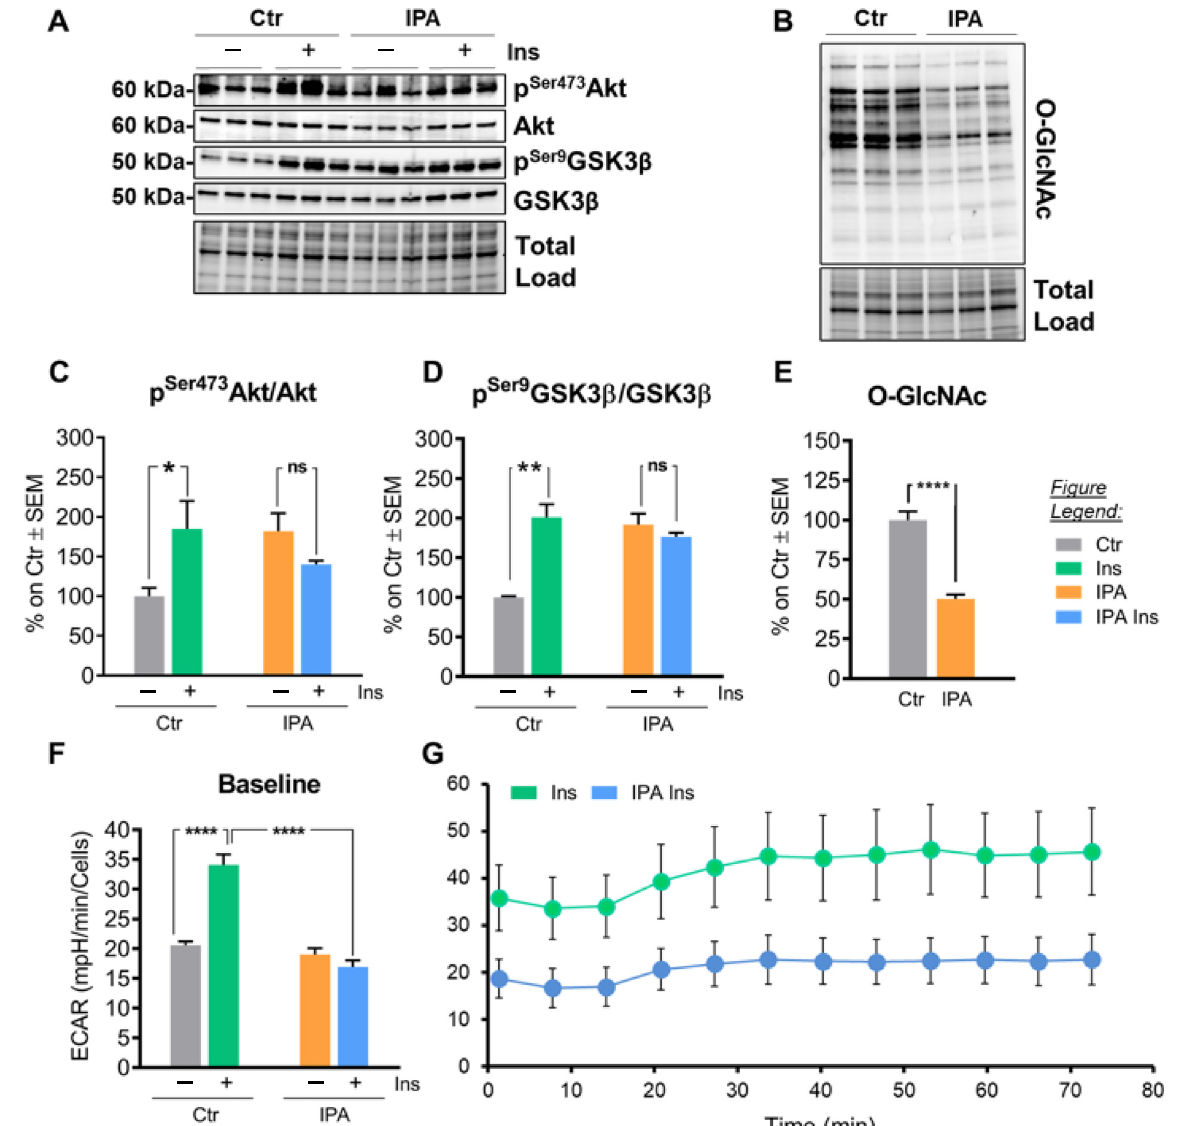
Figure 7. Insulin and palmitic acid (IPA) treatment in SHSY-5Y neuroblastoma cells lead to insulin resistance and reduced protein O-GlcNAcylation. ( A,C ): Analysis of Akt activation status in IPA-treated cells under the stimulus of insulin. Control cells rapidly responded to the insulin stimulus by phosphorylating Akt on Ser473, while IPA-treated cells did not show relevant changes in pSer473Akt/Akt ratio under the stimulus of insulin. Representative blots are reported in ( A ). ( A , D ) Analysis of GSK3 β activation status in IPA-treated cells under the stimulus of insulin. GSK3 β was phosphorylated on Ser9 by Akt in control cells treated with insulin, while IPA pretreated cells were not responsive. Representative blots are reported in ( A ). ( B , E ) Evaluation of global O-GlcNAcylated proteins in IPA-treated cells compared to controls. IPA treatment induced a significant reduction in the overall levels of O-GlcNAcylated proteins. Representative blot is reported in ( B ). ( F , G ) Bioenergetic profile of neuroblastoma cells after insulin treatment. The glycolytic flux, obtained by measuring extracellular acidification rate (ECAR) by Seahorse experiments, of +/ − IPA pretreated neuroblastoma cells after +/ − 30 ′ of insulin incubation. In ( F ) the basal average value of +/ − IPA treated and +/ − insulin stimulated cells is shown; in ( G ) the time-course of the insulin sample +/ − IPA pretreatment is shown. The time-course of non-stimulated cells is shown in Figure S2. A sample experiment is shown. Number of replicates for each condition were as follow: n = 6/group for Western blot analysis and n = 16/group for Seahorse experiment. All bar charts reported in ( C , D ) and ( E , F ) show mean ± SEM. Bar charts reported in ( G ) show mean ± SD. * p < 0.05, ** p < 0.01, **** p < 0.0001, ns = not significant using Student’s t test and 1-way ANOVA.